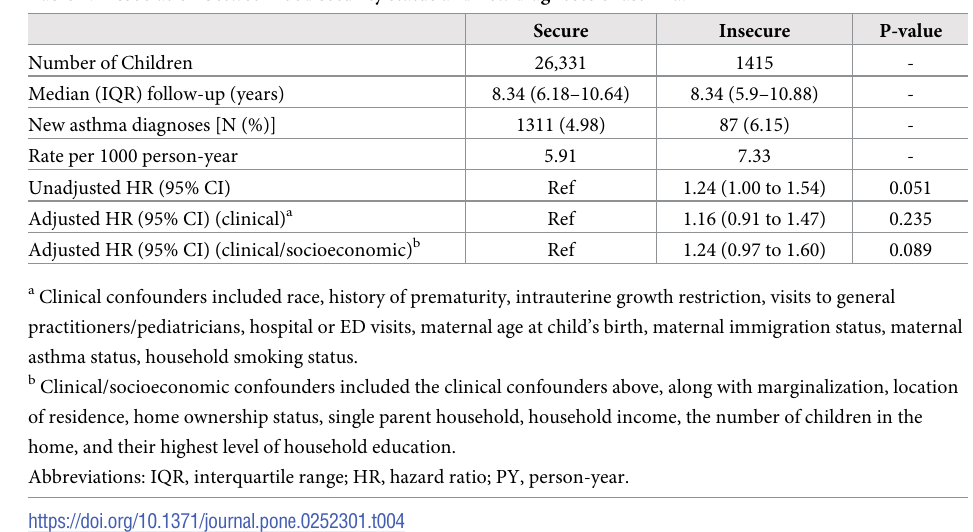
Table 4. Association between food security status and new diagnoses of